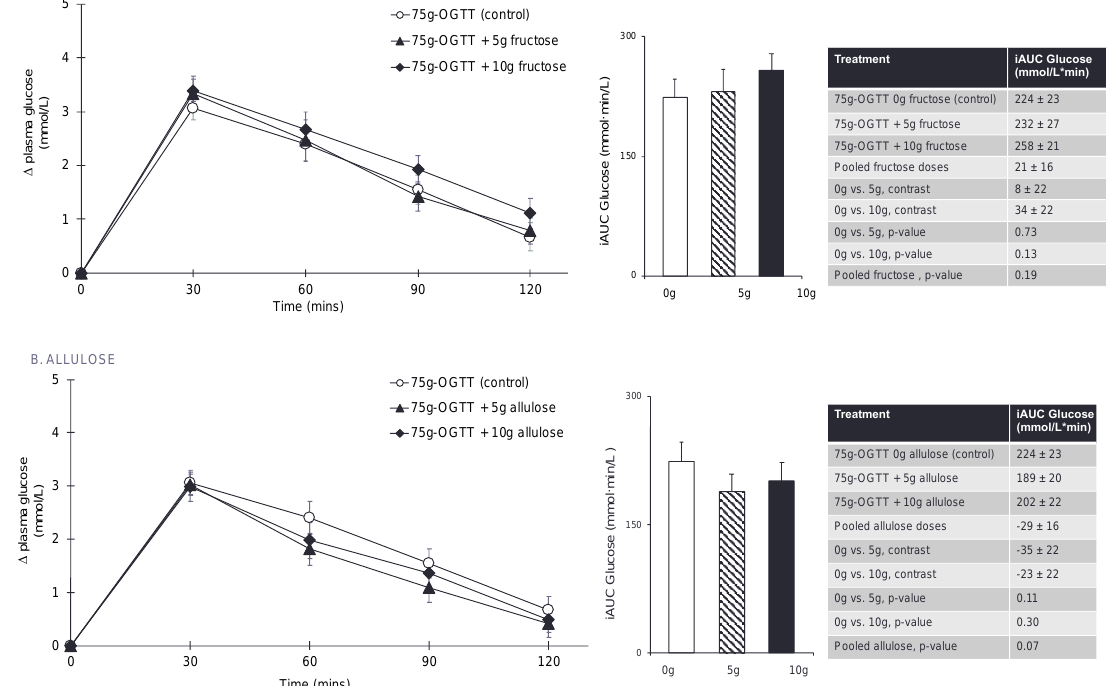
Figure 1. ( A ) Effect of small doses (5 g and 10 g) of fructose on incremental change in plasma glucose and the primary outcome incremental area under the curve (iAUC) for plasma glucose following consumption of 75 g-OGTT (control), 75 g-OGTT + 5 g fructose and 75 g-OGTT + 10 g fructose in 25 healthy participants. ( B ) Effect of small doses (5 g and 10 g) of allulose on incremental change in plasma glucose and the primary outcome of incremental area under the curve (iAUC) for plasma glucose following consumption of 75 g-OGTT (control), 75 g-OGTT + 5 g allulose and 75 g-OGTT + 10 g allulose in 25 healthy participants. Data reported as mean ± SEM. p < 0.05 was considered significant. Note that 5–10 g of fructose is 1–2% of total daily calories and allulose given at doses of 5–10 g contributes 0.05–0.1% of total daily calories in a 2000 kcal diet.